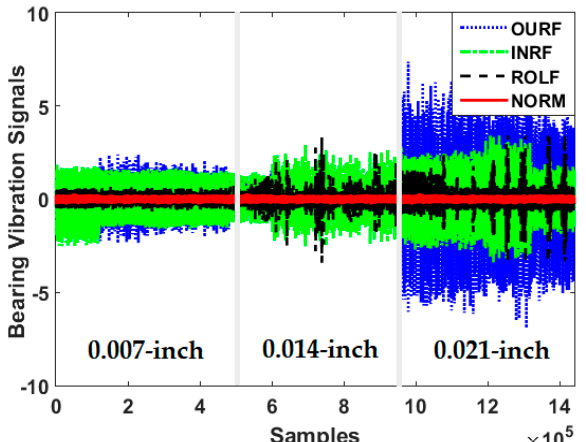
Figure 2. Bearing vibration signals for normal bearings and for ball, inner, and outer faults. The normal Raw signal of bearing and the resampled RMS signal for the normal condition is illustrated in Figure 3.